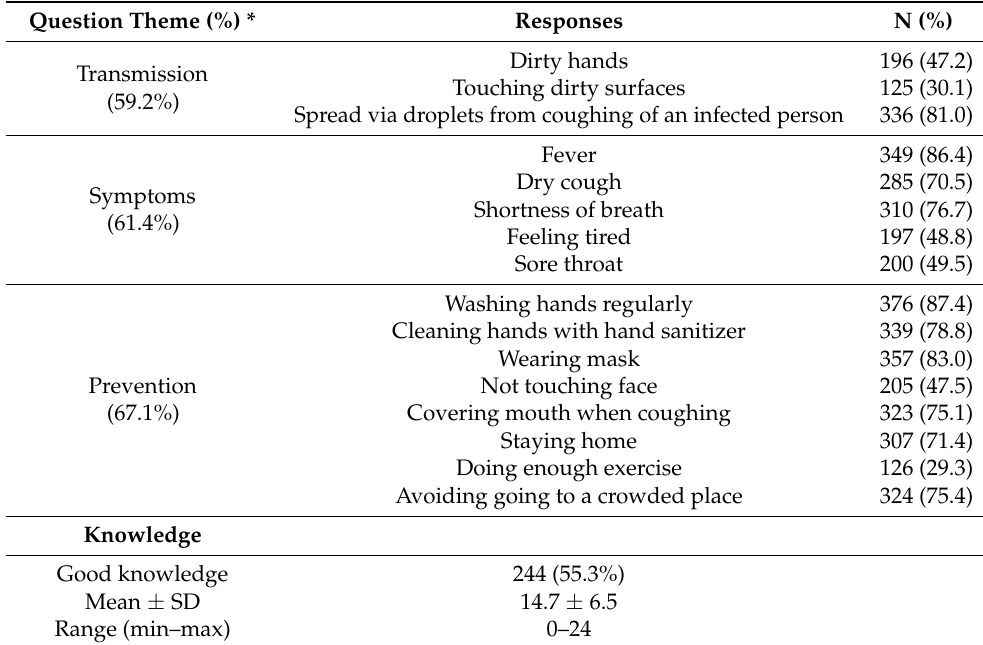
Table 2. Proportion of participants with good responses to the knowledge items of the questionnaire of study participants, Phuentsholing Hospital,